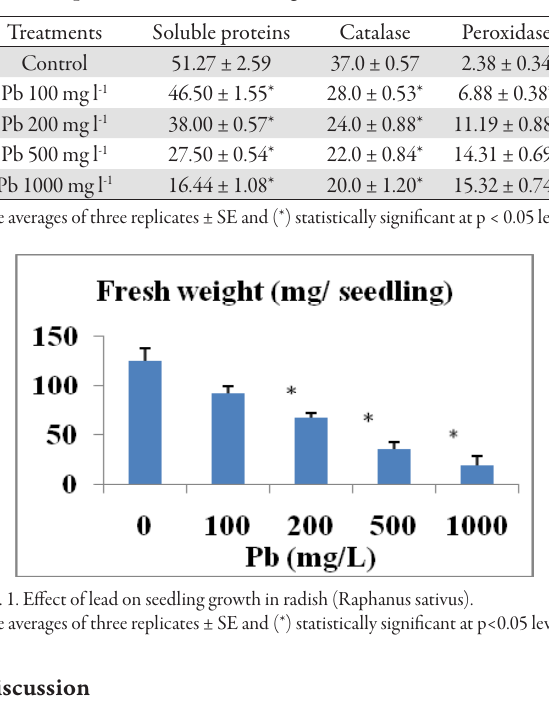
Tab. 3. Effect of lead on soluble proteins (µg/g fresh tissue